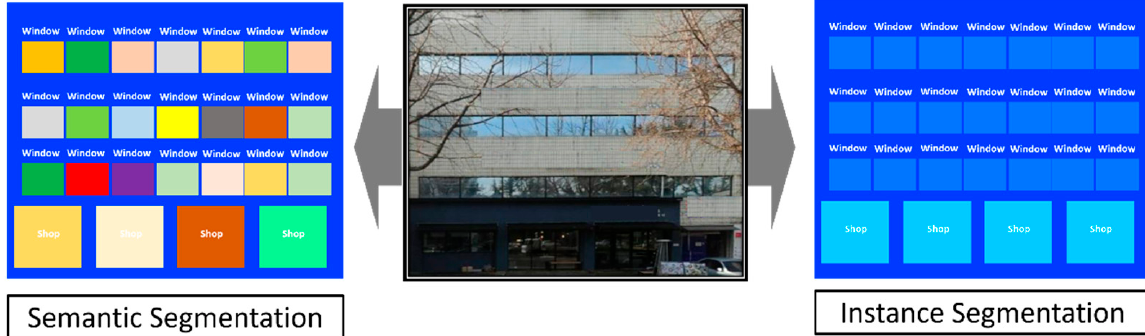
Figure 1. Concept of semantic segmentation and instance segmentation.